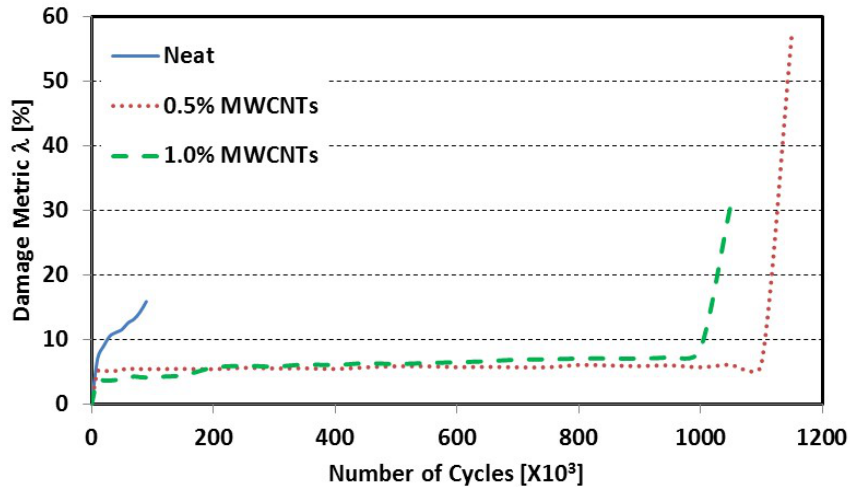
Figure 5. Median λ -N curve for the GFRP specimens with and without MWCNTs.